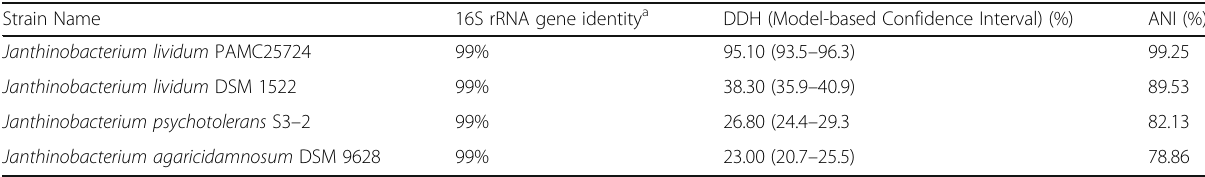
Table 5 Sequence identity of Janthinobacterium lividum ERGS5:01 with validly described species of genus Janthinobacterium ; 16S rRNA gene sequence identity and whole genome sequence-based in silico comparison for DDH and